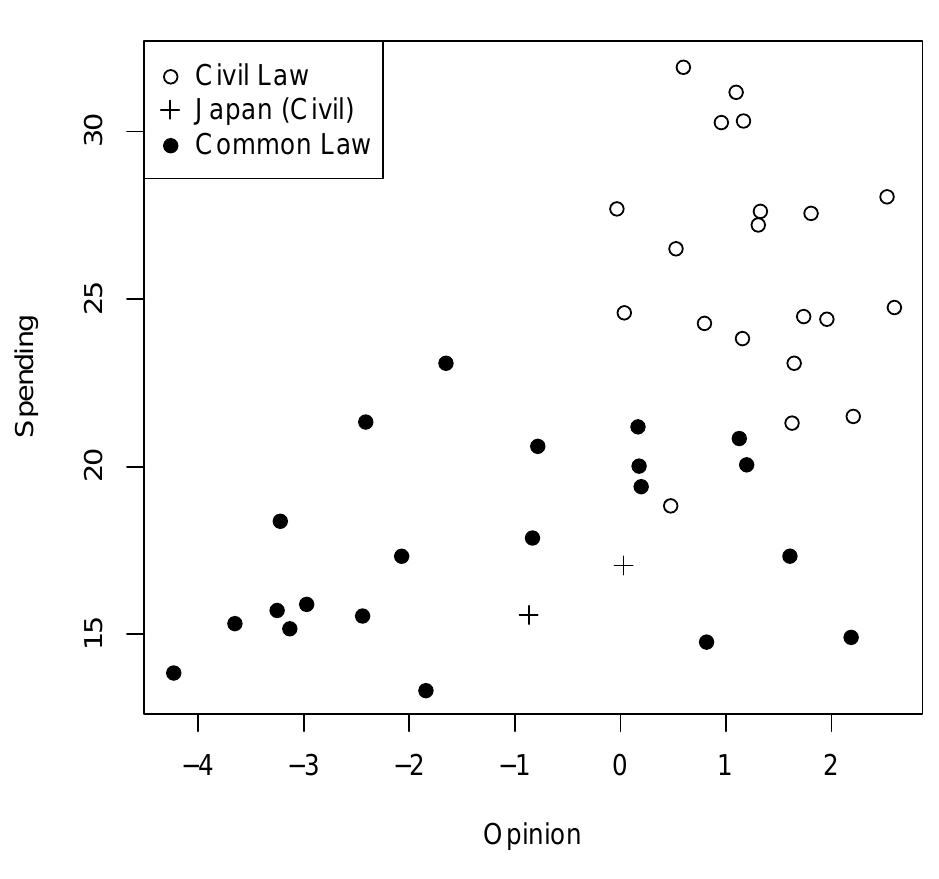
Figure 1: Public Opinion and Welfare